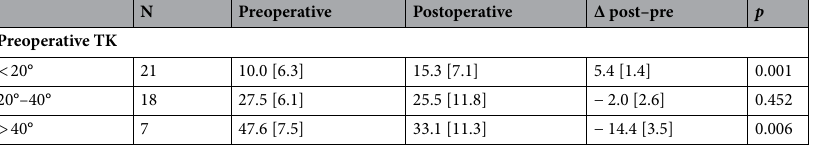
Table 6. Thoracic kyphosis variation in group 2 (hybrid group); patients subgroups according to preoperative thoracic kyphosis; mean [standard deviation]; analysis performed using IBM SPSS Statistics 21. N, number of patients; TK, thoracic kyphosis.